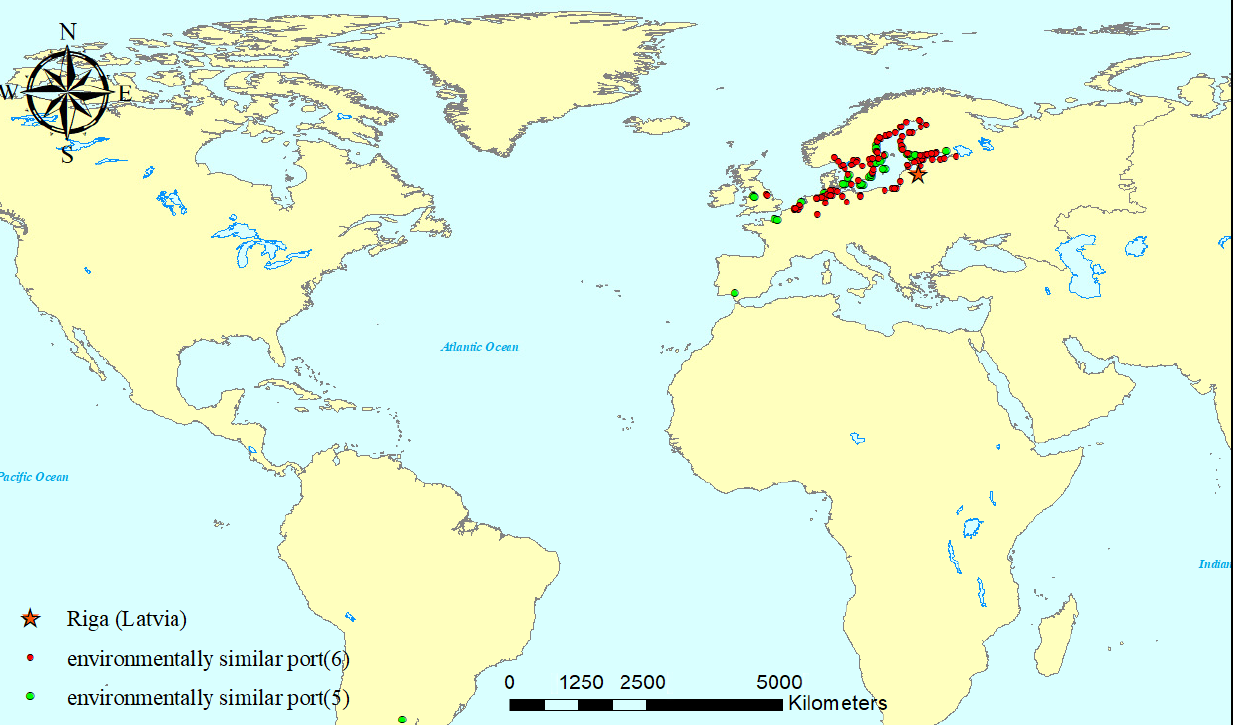
Tier two Tier one